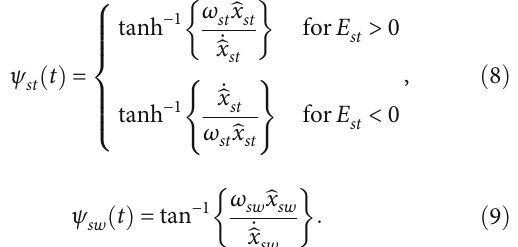
Figure 2: Two-link model (compass gait model) with the stance leg and swing